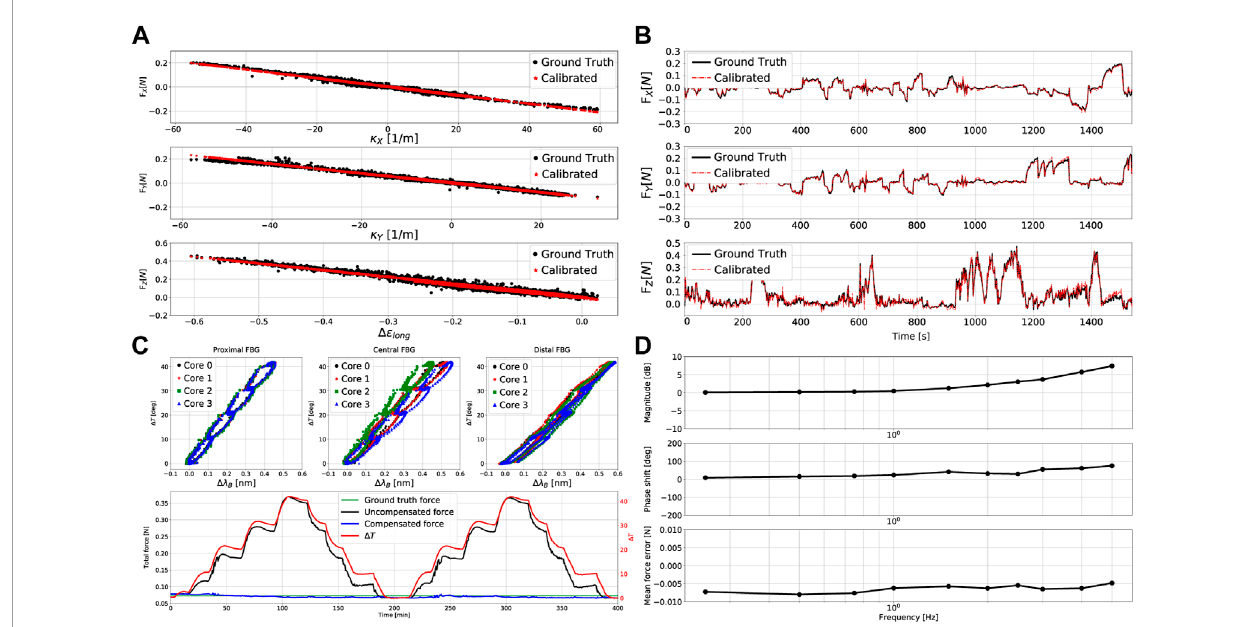
FIGURE 7 Catheter tip force sensor calibration results: (A) relationships between the 3D measured and calibrated forces versus input measurements κ x , κ y and Δ ϵ long , (B) comparison of the ground truth and estimated 3D forces for different force configurations across time, (C) relationships between temperature change and wavelength shift for the three FBG sets, and comparison of temperature compensated and temperature uncompensated force estimations, (D) dynamic frequency-based force estimation bode plot and mean force error versus frequency.